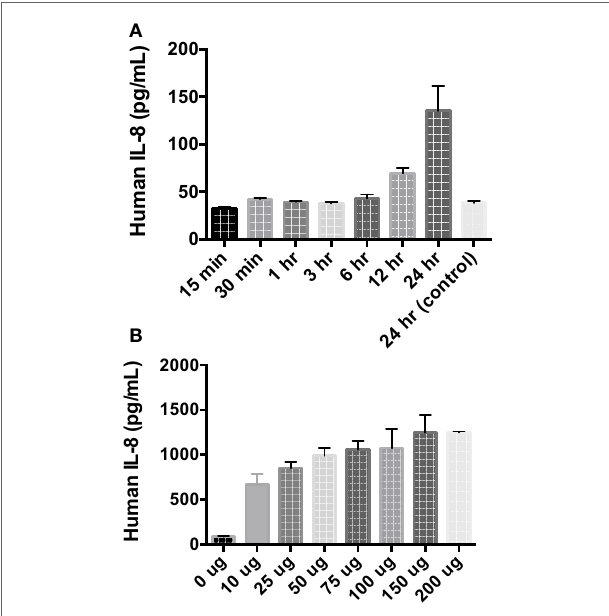
FigUre 2 | Temporal and dose dependency of Alt a 1 induced IL-8 in BEAS-2B cells. (a) 2.0 × 10 5 BEAS-2B cells were grown in RPMI + FBS + 1% Pen Strep. Cells were starved for 6 h prior to induction with rAlt a 1 or endotoxin-free sterile PBS. The starve media consisted of RPMI + 1% Pen Strep without FBS. Cells were treated with 50 µg rAlt a 1 for the specified time. Supernatants were collected and assayed via BIOLEGEND IL-8 ELISAMAX. After testing for homogeneity of variances, Tukey’s HSD was performed and adjusted (* p < 0.001). Data are represented as mean (SD). Comparisons were made between rAlt a 1 treated and untreated cells (PBS-treated 24 h control). (B) 5 × 10 5 BEAS-2B cells were grown in RPMI + FBS + 1% Pen Strep. They were then starved for 6 h. The starve media was RPMI + 1% Pen Strep. Cells were treated with rAlt a 1 or PBS (0 μ g) for 24 h. Media was collected and assayed via BIOLEGEND IL-8 ELISAMAX. Data are represented as mean (SD). Comparisons were made between Alt a 1-treated and control PBS-treated cells (* p <